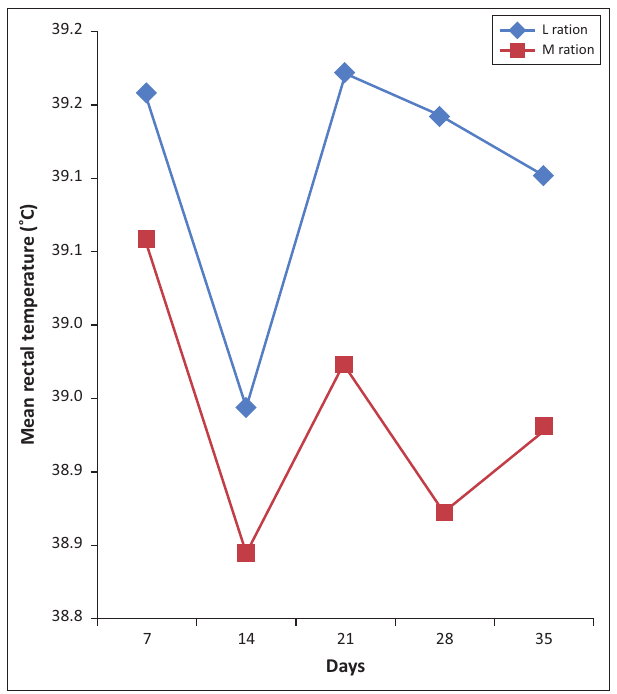
FIGURE 1: The effect of feeding a Lespedeza cuneata or Medicago sativa hay FIGURE 2: The effect of feeding Lespedeza cuneata or Medicago sativa hay on ration on the faecal egg count of parasitised sheep in the trial with indication of the mean rectal temperature (°C) of parasitised sheep. the critical faecal egg count level according to Colditz TABLE 2: The faecal egg count results (Log TABLE 3: The rectal temperatures (°C) of sheep on a Lespedeza cuneata or transformations) of sheep on e Medicago sativa hay ration. different days on a Lespedeza cuneata or Medicago sativa hay ration. Days FEC (Log e transformations) for Time Rectal temperature (°C) for sheep fed different rations sheep fed different rations